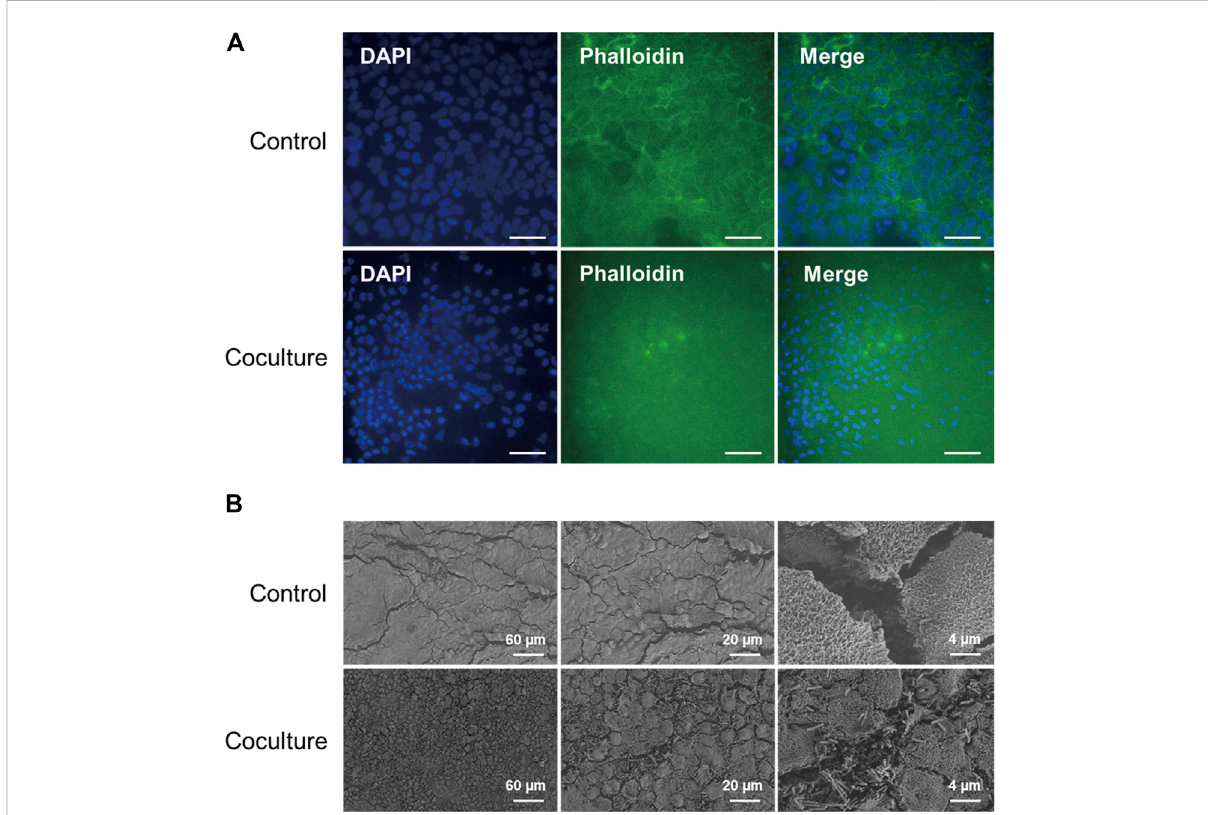
FIGURE 3 (A) Immuno fl uorescence microscopy images of Caco-2 cells in accordance with coculture with C. dif fi cile at 48 h. F-actin is stained with phalloidin(green),andcellnucleiarestainedwithDAPI(blue).ControlmeansmonocultureofCaco-2cells.Scalebarsrepresent50 µm. (B)